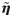
Results of ABA- simulations of the model under different values of Δ and σ.(a) The proportion of time spent in segregation. Small σ corresponds to fast sequences and vice versa, as indicated below the abscissa. (b) Duration of the initial integration percept in input elements count, shown in log values. Dark blue squares indicate conditions in which the initial percept was of segregation. In all simulations, the initial value for π2 was 0.001, γ = 0.1, η˜
=
0.05, and the shape of the conditional likelihood was generalized normal with β = 0.5 and a variance of 1. The mixture was initialized with two classes centered at A and B, and π2 was initially 0.001. Simulations were deterministic. On-going switching occurred in all simulations. (c) The time course of build-up, quantified as the probability of segregation among 100 stochastic simulations of each of Δ, for σ = 4. The thin line above and below each trace mark the standard error of the mean.